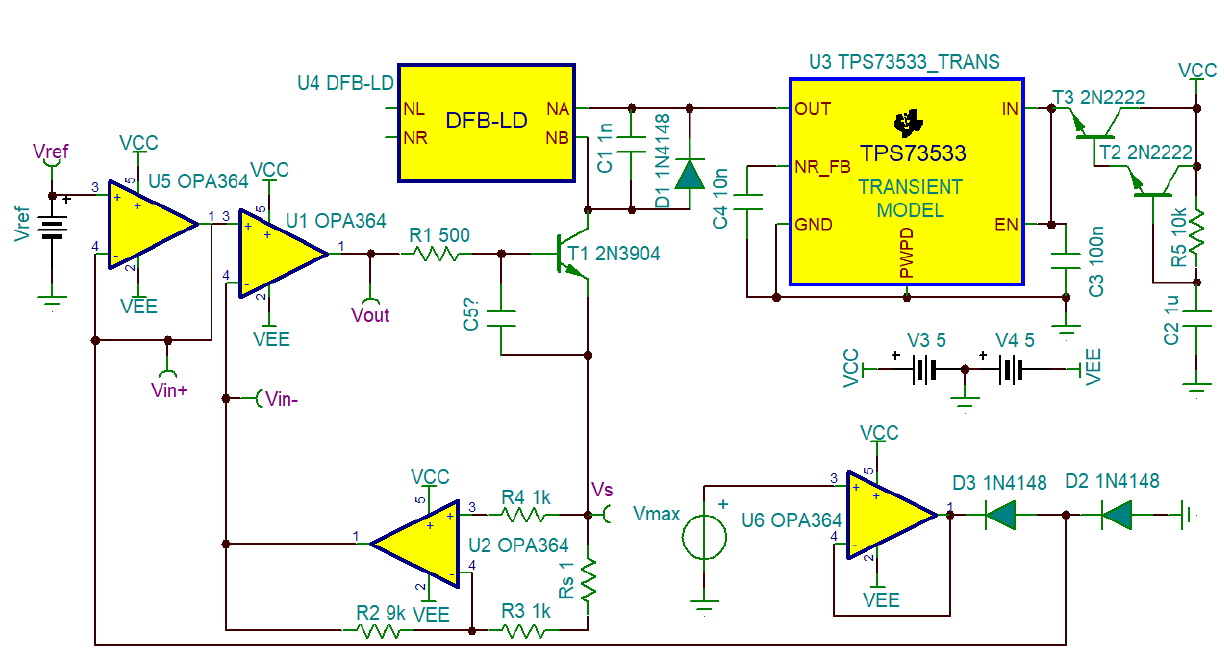
Figure 4. The float-ground type current